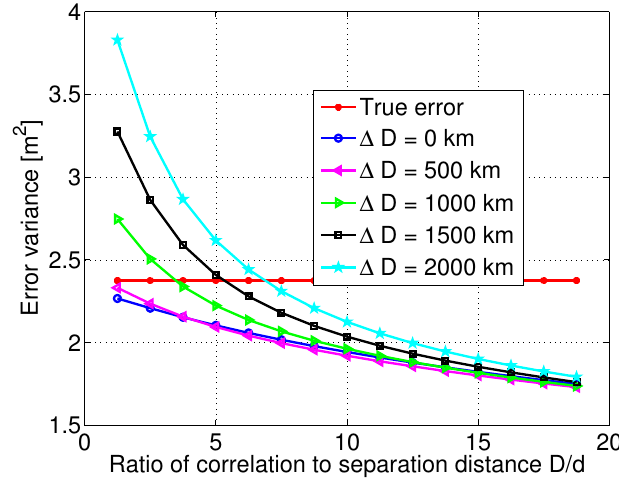
Figure 9. Estimation error variance corresponding to a sum of three Gauss-Markov processes and different ∆ D modeling errors.